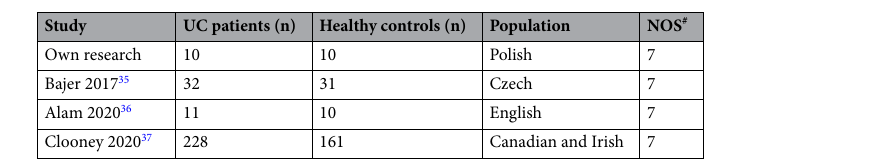
Table 2. Characteristics of included studies. # Newcastle Ottawa scale (NOS) used to assess the quality of bias